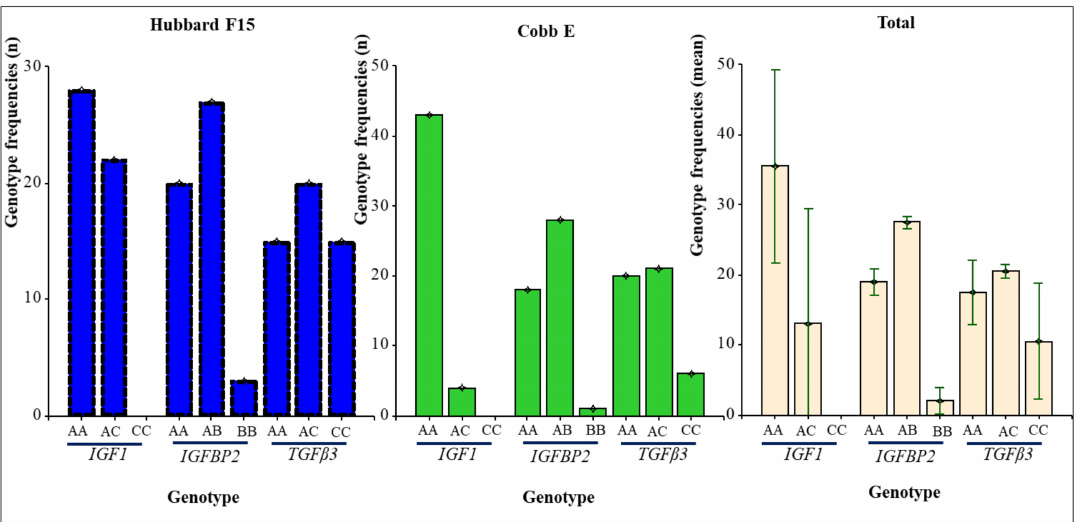
Figure 3. Genotype distribution of individual genes in both chicken lines.